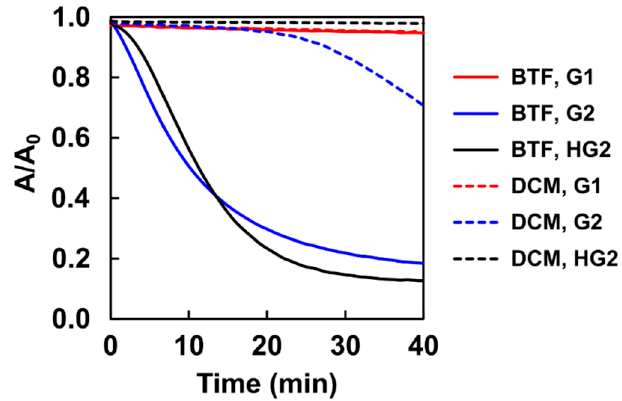
Figure 3. The consumption (A/A 0 ) of (Z)-but-2-ene-1,4-diyl diacetate (c 0 = 55.2 mM) as a function of time in the isomerization reaction in the presence of 0.1 mol% of ruthenium catalysts, G1, G2, and HG2 in benzotrifluoride and dichloromethane solvents at 25 °C (A: 1 H NMR signal integral of the vinylic hydrogen signal of (Z)-but-2-ene-1,4-diyl diacetate; and A 0 : initial 1 H NMR signal integral of the vinylic hydrogen of (Z)-but-2-ene-1,4-diyl diacetate; see Figure S5). Table 4. The solvent, the catalyst, rate constant, and the conversions after 20 min and 24 h of the isomerization of (Z)-but-2-ene-1,4-diyl diacetate (c 0 = 55.2 mM) in benzotrifluoride (BTF) and dichloromethane (DCM) using 0.1 mol% G1, G2, and HG2 as catalysts. Solvent